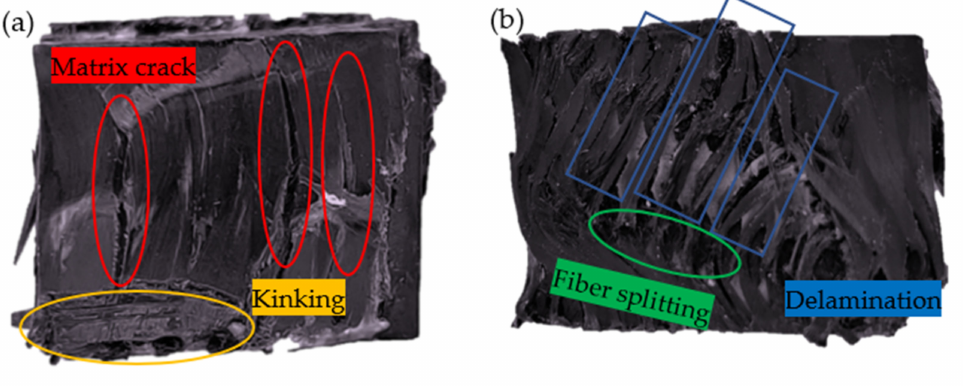
Figure 5. Damage pattern of quasi-static compression test in the warp direction: ( a ) top view; ( b ) side view.